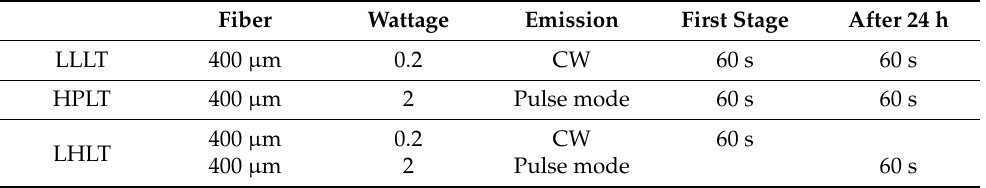
Table 1. Laser parameters used for each study group. LLLT: Low-Level Laser Therapy; HPLT: High-Power Laser Therapy; LHLT: Low–High combined Laser Therapy; CW: Continuous Wave.